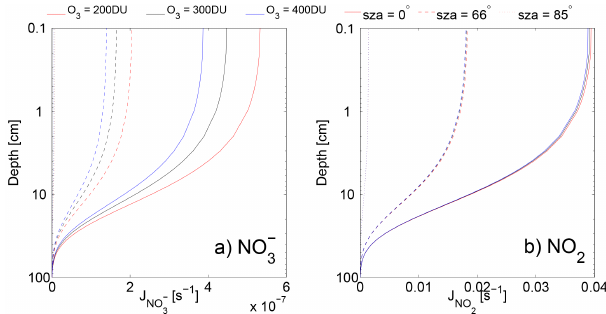
Figure 5. The effect of different column ozone amount on the pho- tolysis rate coefficient of (a) NO − and (b) NO 2 at three selected 3 solar zenith angles (0 ◦ , 66 ◦ and 85 ◦